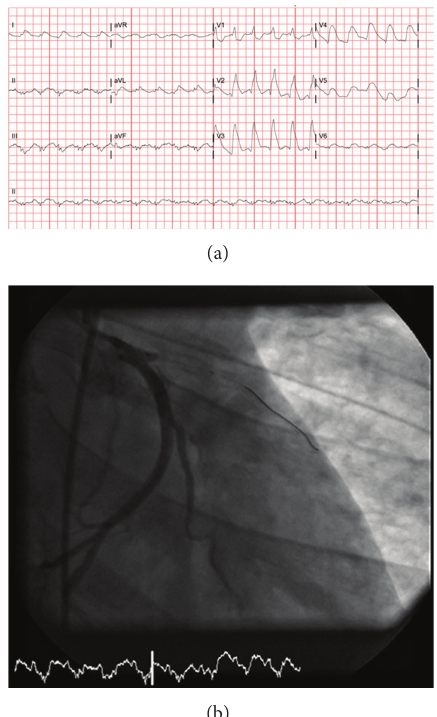
Figure 2: 12-lead EKG showing sinus tachycardia, complete right bundle branch block, and massive ST segment elevation in anterior, anterolateral, and lateral leads. Coronary angiography after balloon angioplasty for stent thrombosis showing no reflow phenomenon, suggesting emboli to microvasculature and possibly nonviable myocardium with interstitial or perivascular myocardial edema.